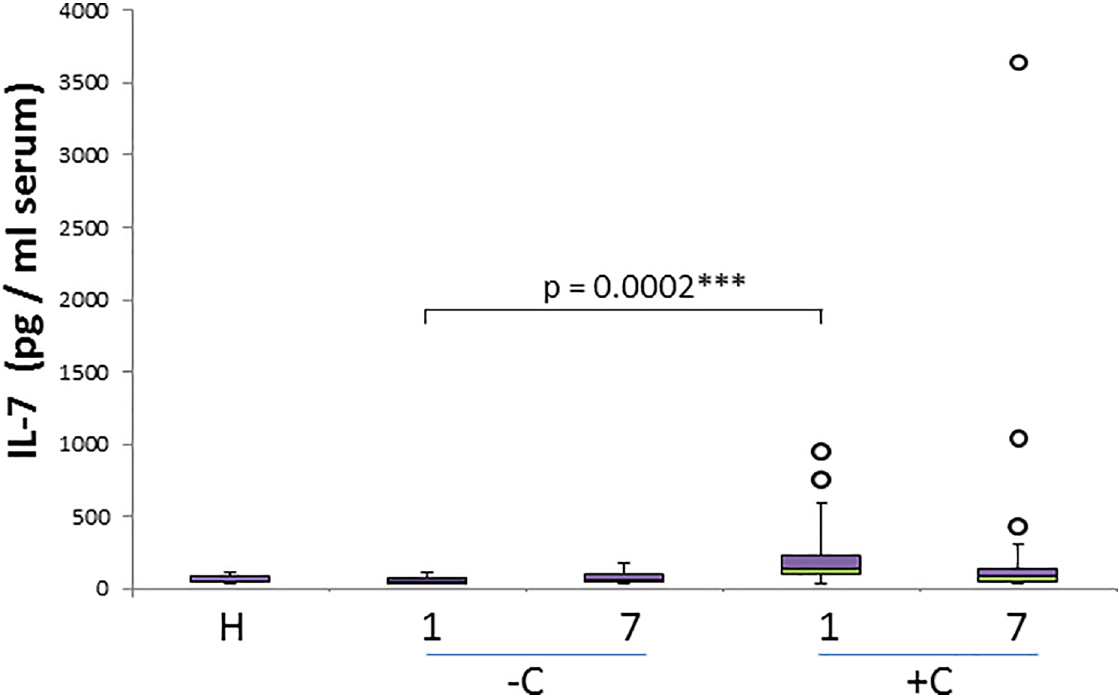
Fig 6. IL-7 concentration in healthy and naturally infected dogs and its relation with outcome. Box and whisker plot with outliers showinginterquartile range (median bar in intersect betweentwo colors in box) of IL-7 concentration values among different groups: healthy dogs (H), uncomplicated (-C) and complicated(+C) cases for both day 1 and day 7. Mann-whitney test p- values are shown for comparison of different groups.